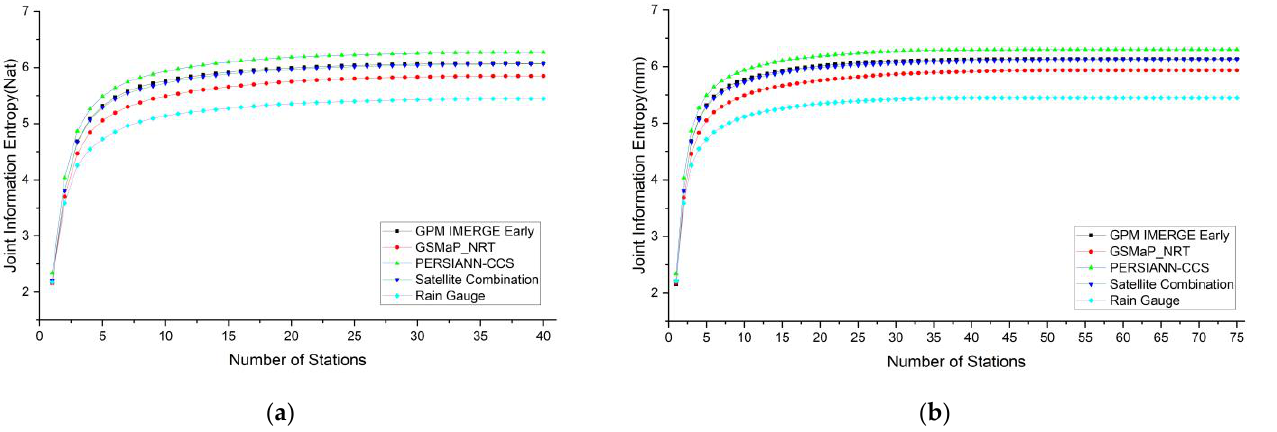
Figure 10. Maximum joint information entropy with different combinations of rain gauge stations.